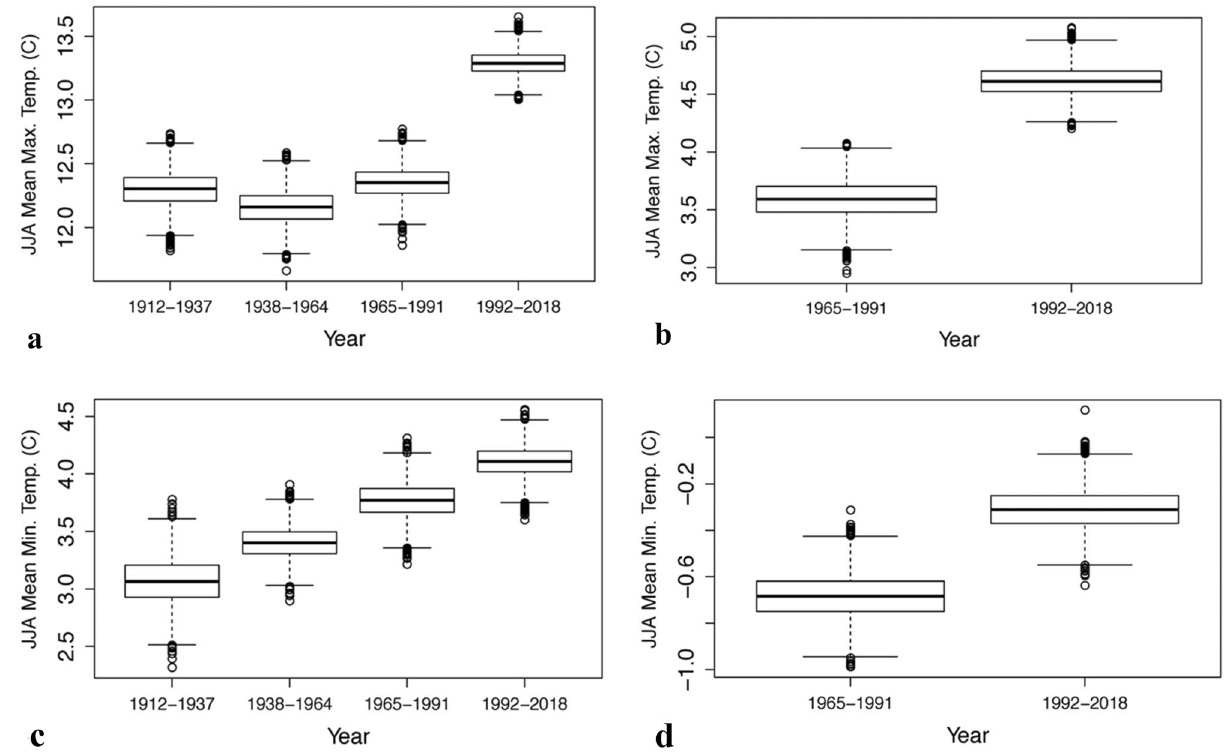
Figure 6. Box plots of mean temperature in the Murrumbidgee River catchment. (a) Bootstrapped 27-year interval Burrinjuck JJA mean TMax (C), ( b) bootstrapped 27-year interval Cabramurra JJA mean TMax (C),